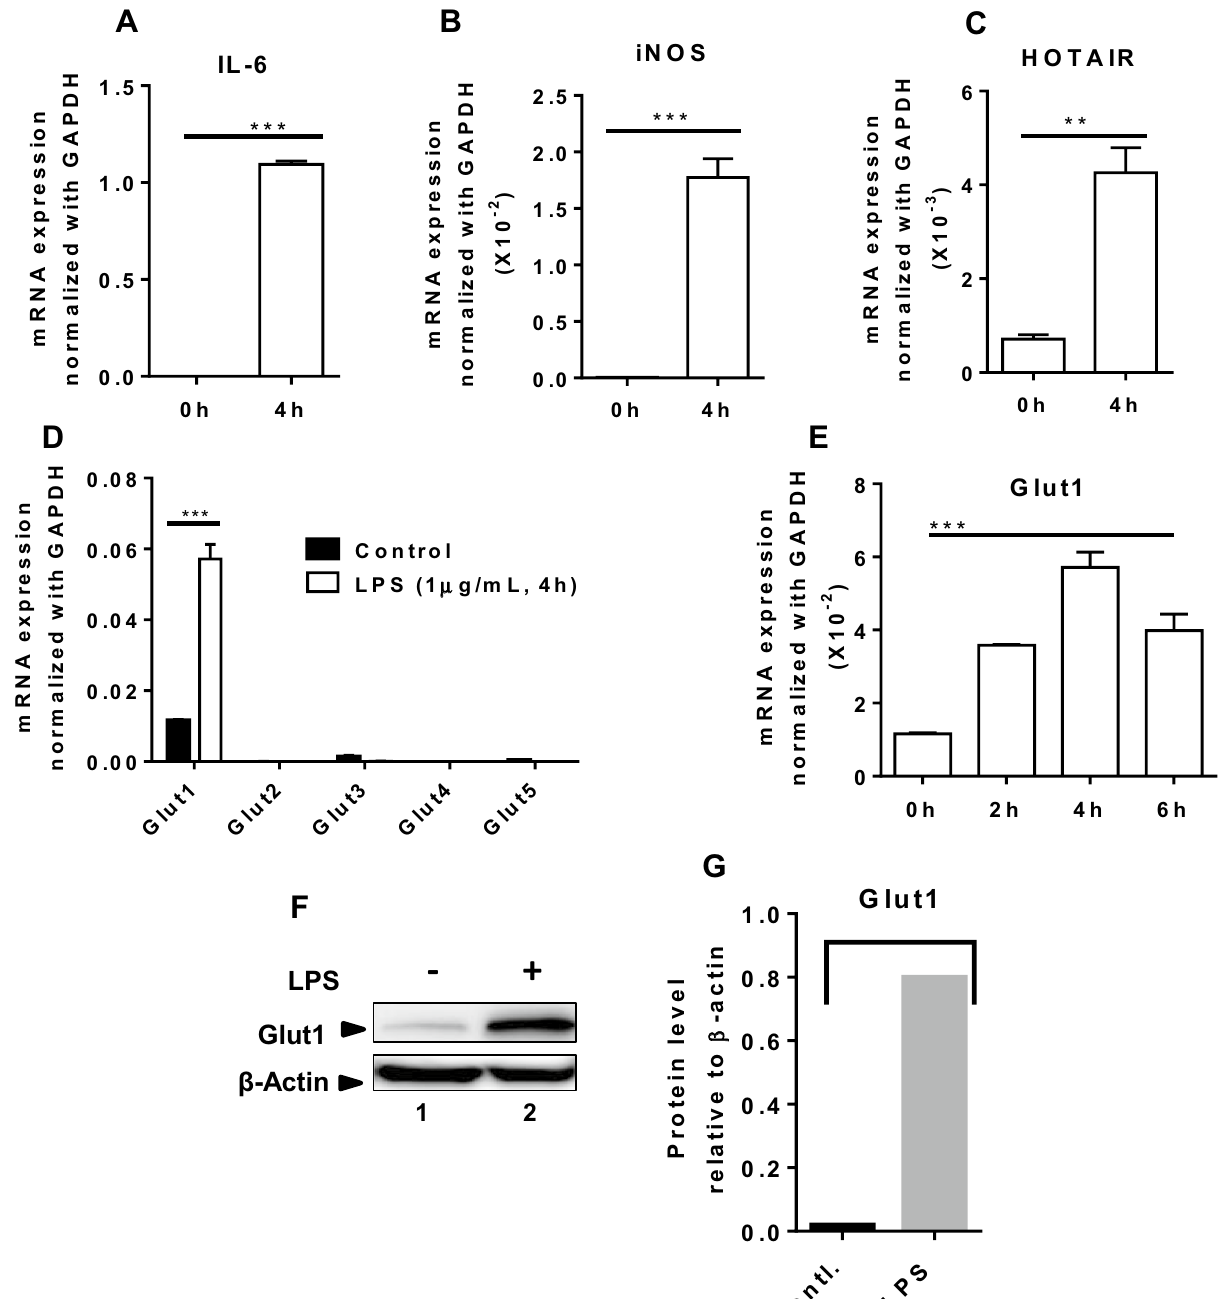
Figure 1. LPS induces Glut1 expression in macrophages. ( A – E ) RAW264.7 cells were treated with LPS (1 μg/ mL) for 4 h (or different time periods), total RNA was isolated, reverse transcribed to cDNA and the expressions of IL-6, iNOS, HOTAIR, and different glucose transporters (Glut1, Glut2, Glut3, Glut4 and Glut5) were analyzed by RT-qPCR. GAPDH was used as control. The expression (relative to GAPDH) of IL-6, iNOS, HOTAIR, Glut1, Glut2, Glut3, Glut4 and Glut5 are shown in panels ( A – D ). The expression of Glut1 at different time periods of LPS-treatment is shown in panel ( E ). ( F – G ) LPS stimulated protein (1 h LPS-treatment) was extracted from macrophages and analyzed by Western blot using antibodies against Glut1 and β-actin (loading control). Quantifications (using ImageLab5.2.1software) is shown in panel ( G ). Each experiment was repeated at least with three parallel replicates. Data represent mean ± SD (n = 3); *p < 0.05, **p < 0.001, ***p <